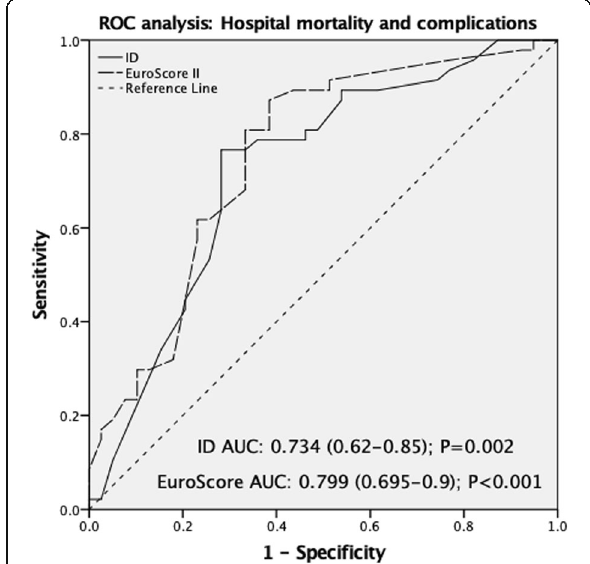
Fig. 4 ROC analysis: hospital mortality and complications: index of deterioration versus EuroScore